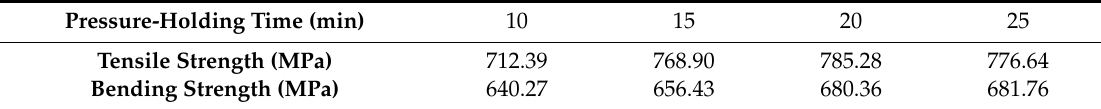
Table 8. E ff ects of pressure-holding time on mechanical performance.